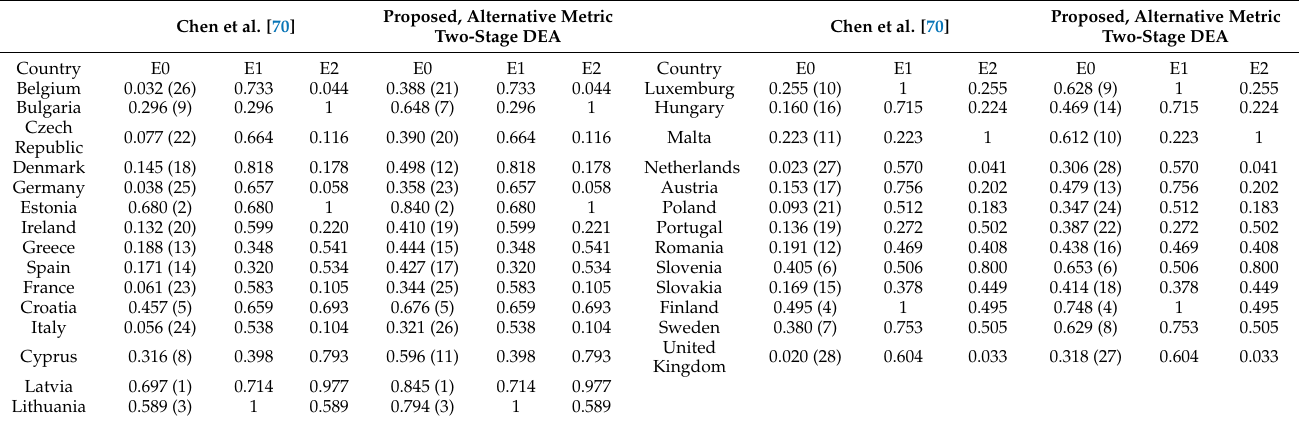
Table 1. Results from the proposed, alternative metric two-stage DEA and the ones obtained by the models of Chen et al.